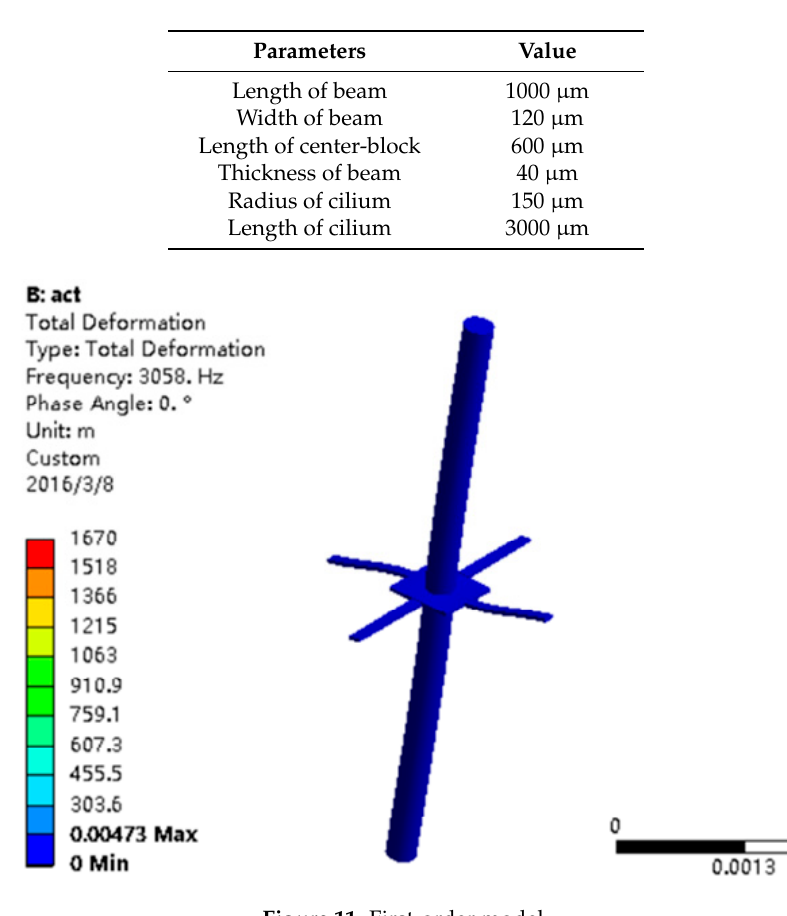
Figure 11. First-order model.